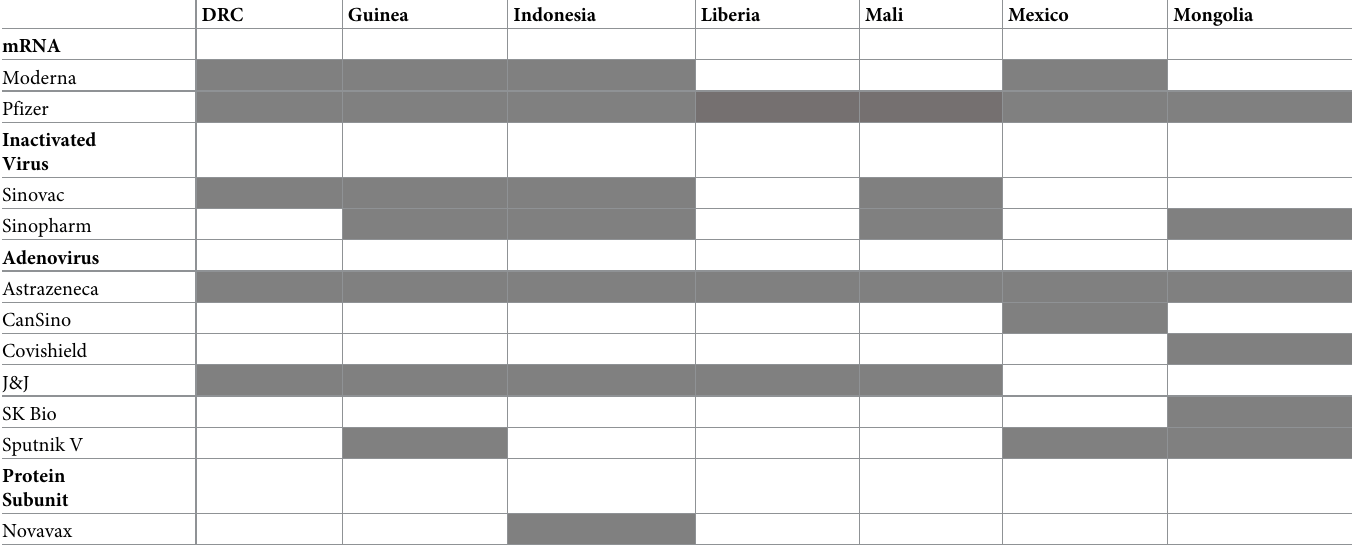
Table 1. Participating countries and vaccines that are available in each participating